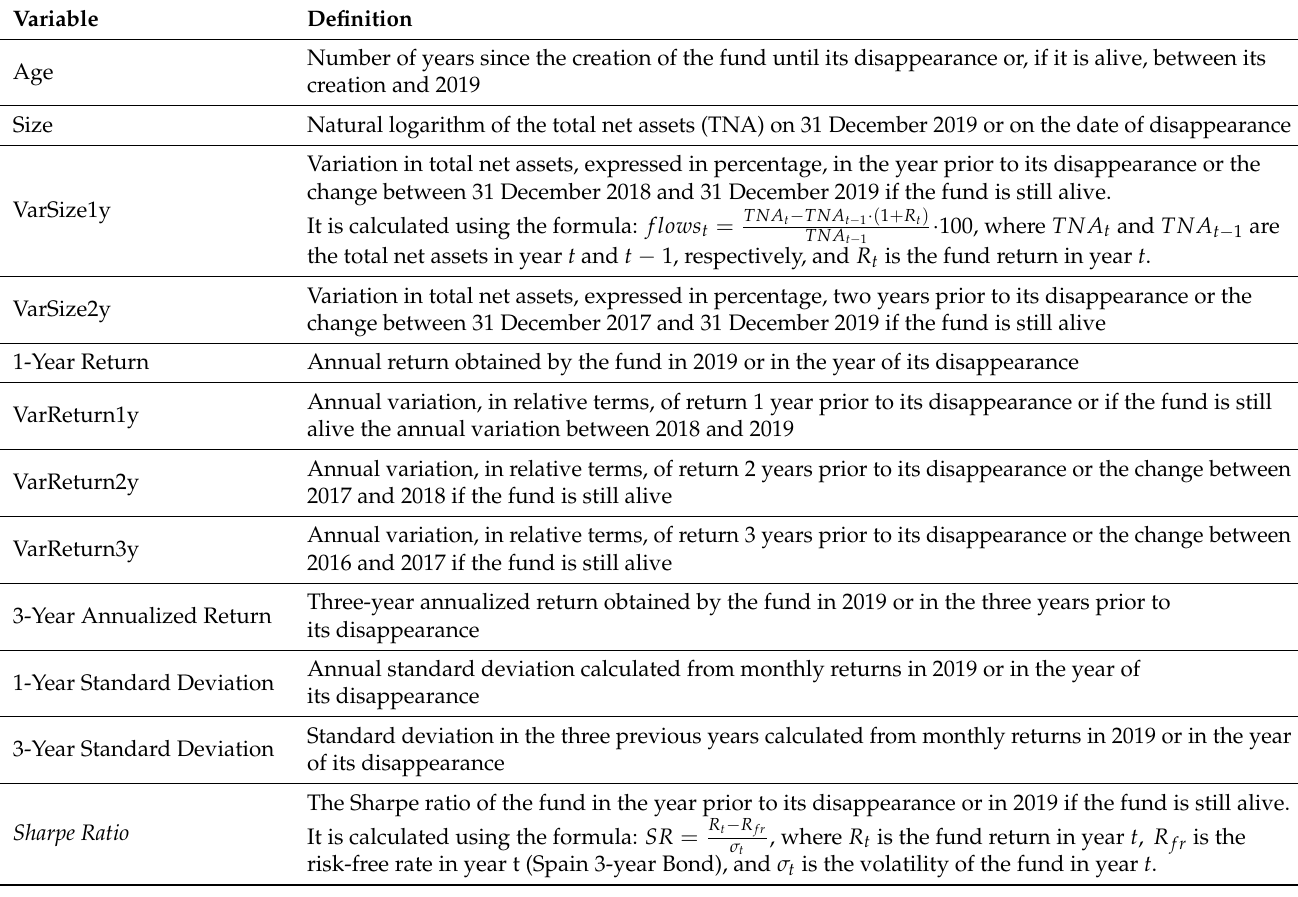
Table 1. List and definition of